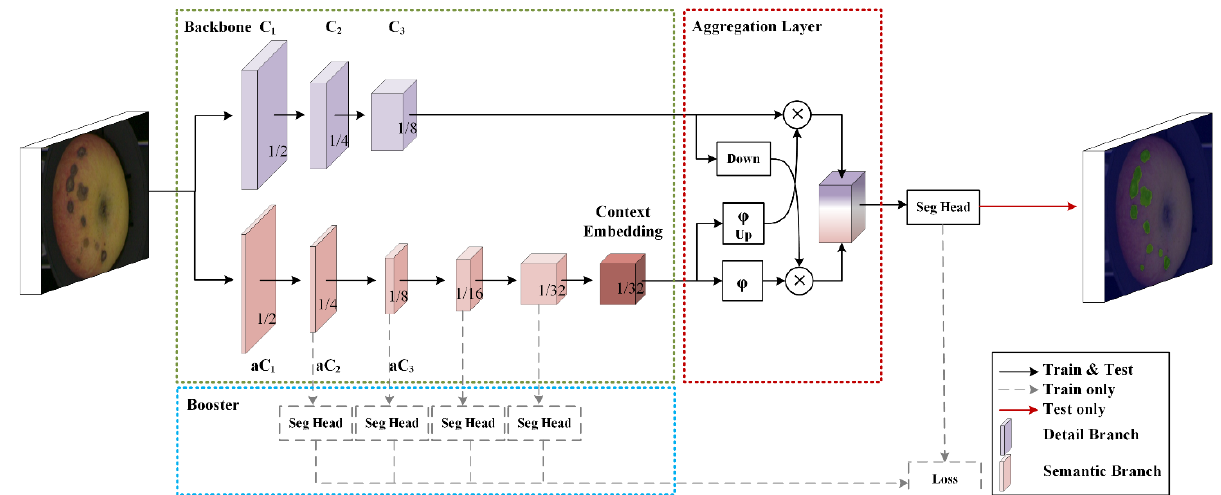
Figure 2. The architecture of BiSeNet V2 network.